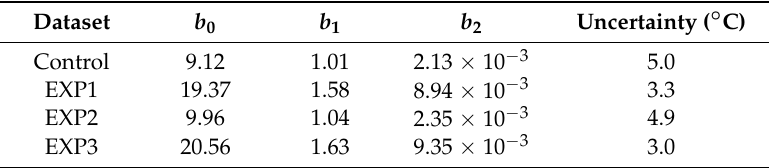
Figure 3. The scatter diagram of the simulated clear sky Tb (Tb S ) and the Tb IRT (potentially clear sky Tb). The best-fit lines (black, blue, red, and green for the Control, the EXP1, the EXP2, and the EXP3, respectively) represent Equation (A2), while the dashed line is the one-to-one line. Table 4. The coefficients for the quadratic formulas of Equation (A2) of Appendix A for the four experimental datasets. The uncertainty represents a fitting error as a standard deviation of the difference between Tb IRT and estimated Tb E CLR . The uncertainty is used as a threshold value for the spectral